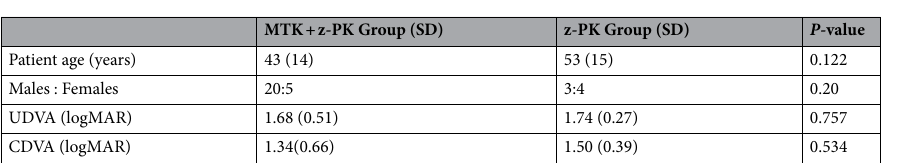
Table 1. Baseline characteristics of the MTK + z-PK Group and z-PK group patients. MTK microwave thermokeratoplasty, z-PK zig-zag penetrating keratoplasty, SD standard deviation, UDVA uncorrected distance visual acuity, logMAR logarithm of the minimum angle of resolution, CDVA corrected distance visual acuity. There was no significant difference when tested with the Student’s t-test.